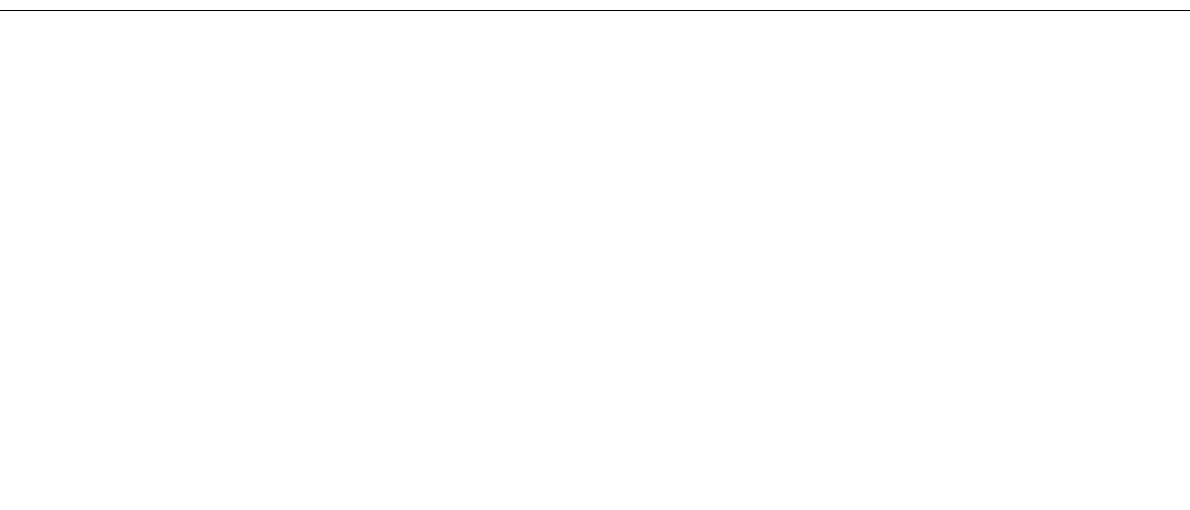
FIGUREA1 | JPG file defining the symbols and relationships depicted in IPA